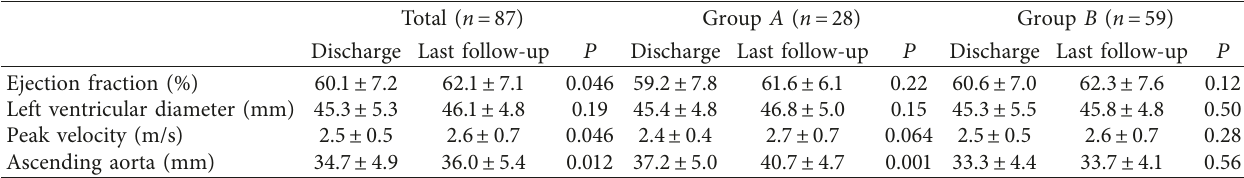
Table 2: Postoperative data.